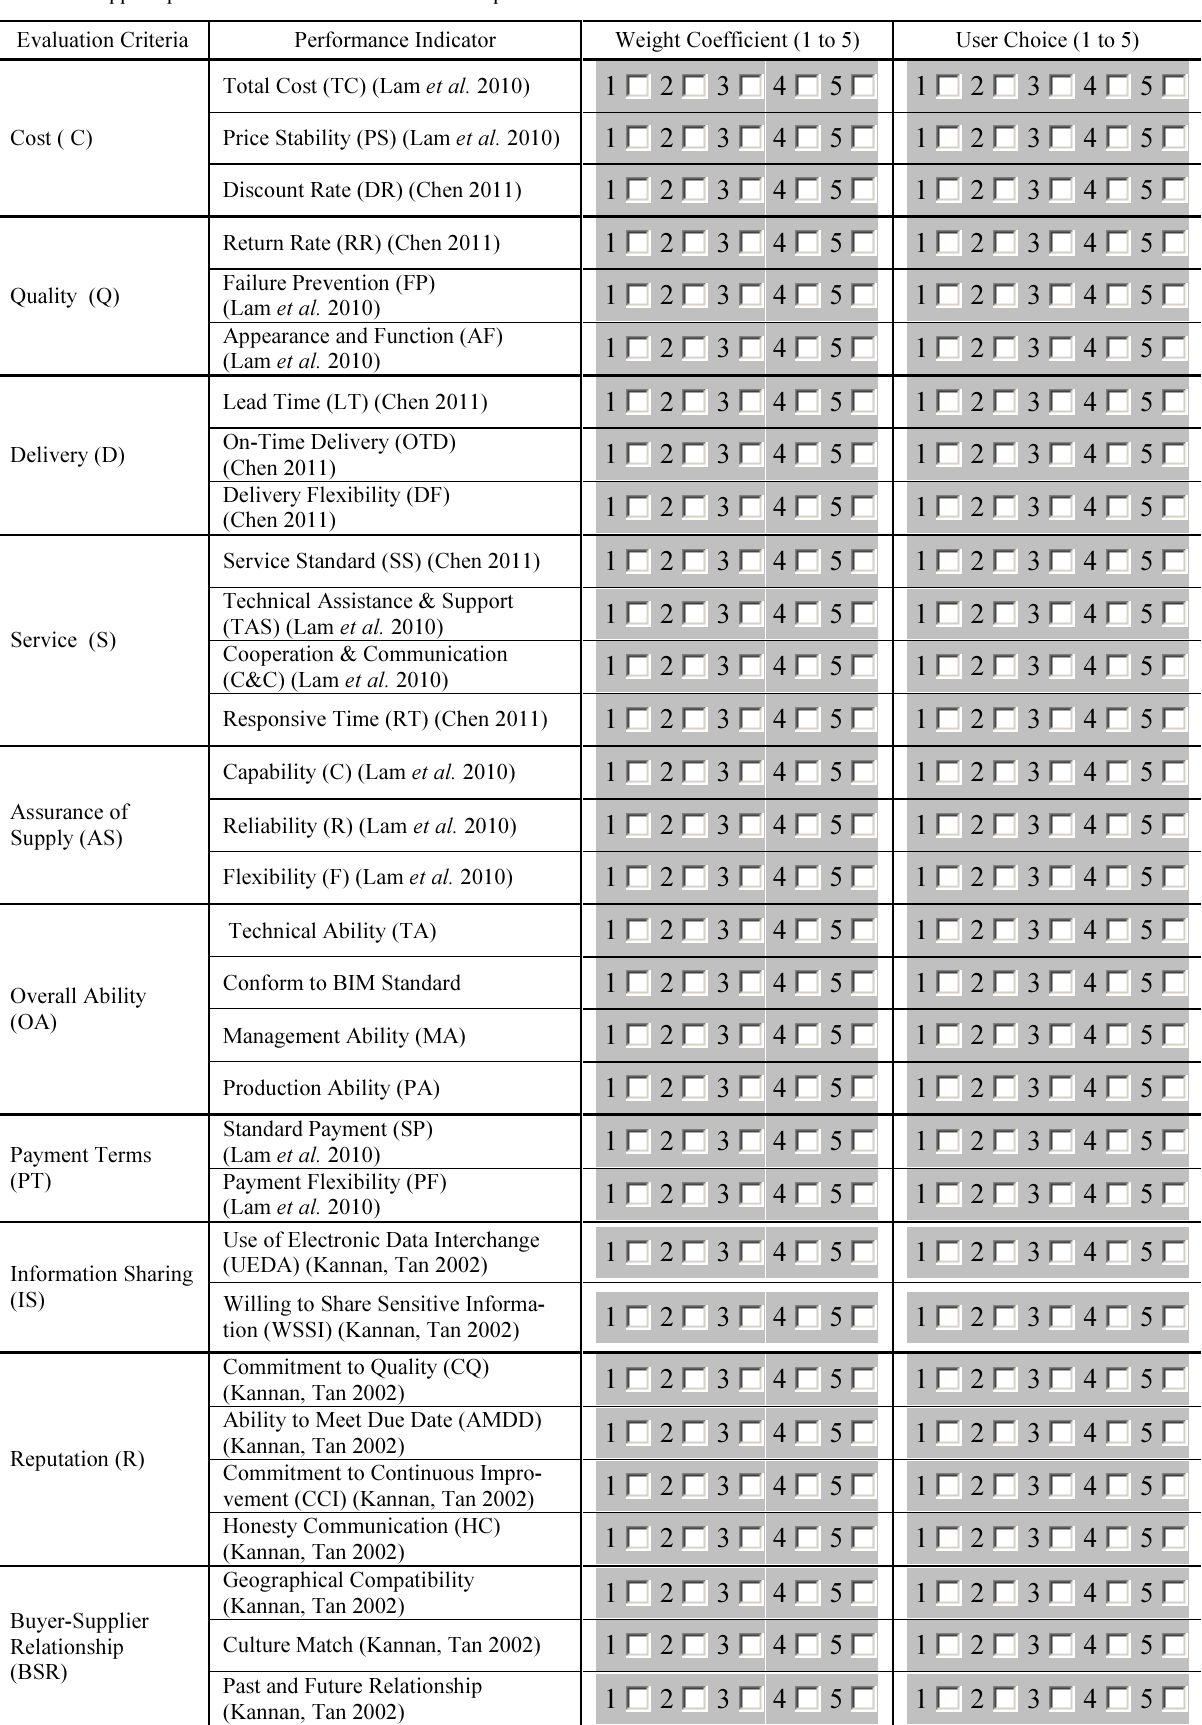
Table 2. Supplier performance evaluation criteria and performance indicators Evaluation